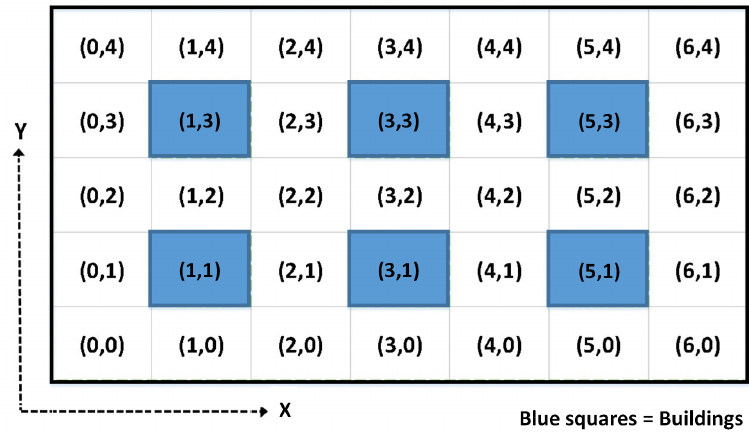
Figure 1. Discrete positions of a vehicle in a Manhattan scenario proposed in